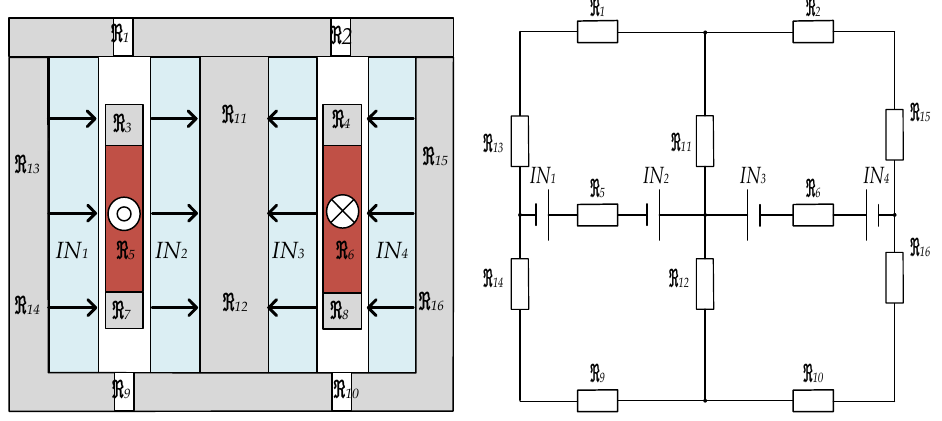
Figure 4. EMFA equivalent magnetic circuit diagram.